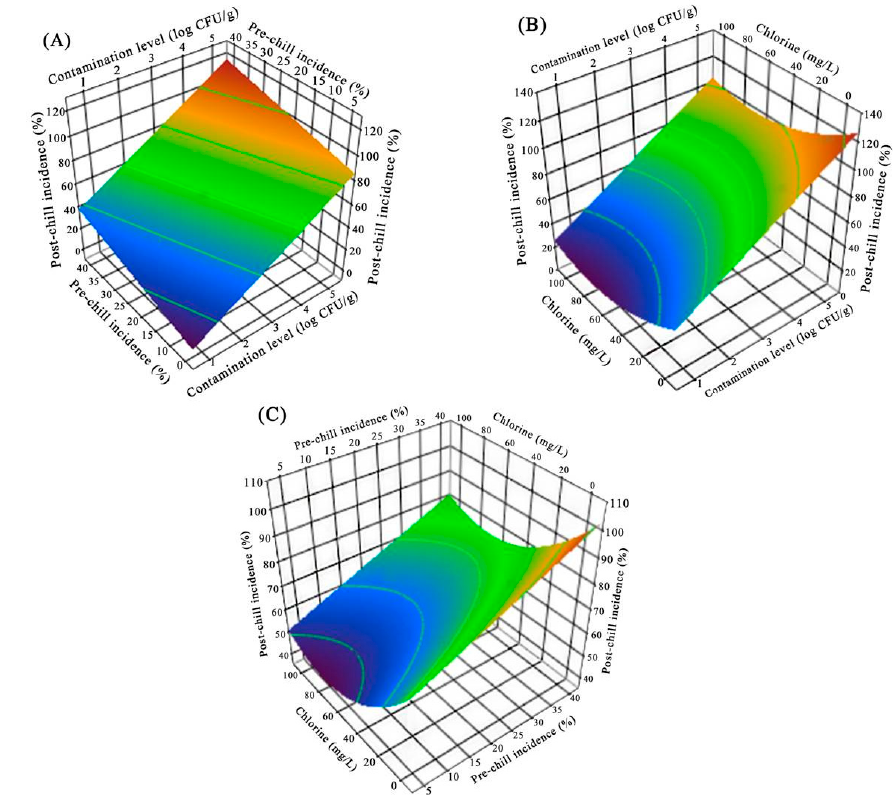
Figure 4. Response surface plots describing the effect of initial contamination level and pre-chill incidence ( A ); initial contamination level and chlorine concentration ( B ); and pre-chill incidence and chlorine concentration ( C ) on post-chill incidence of Salmonella in chilling process.